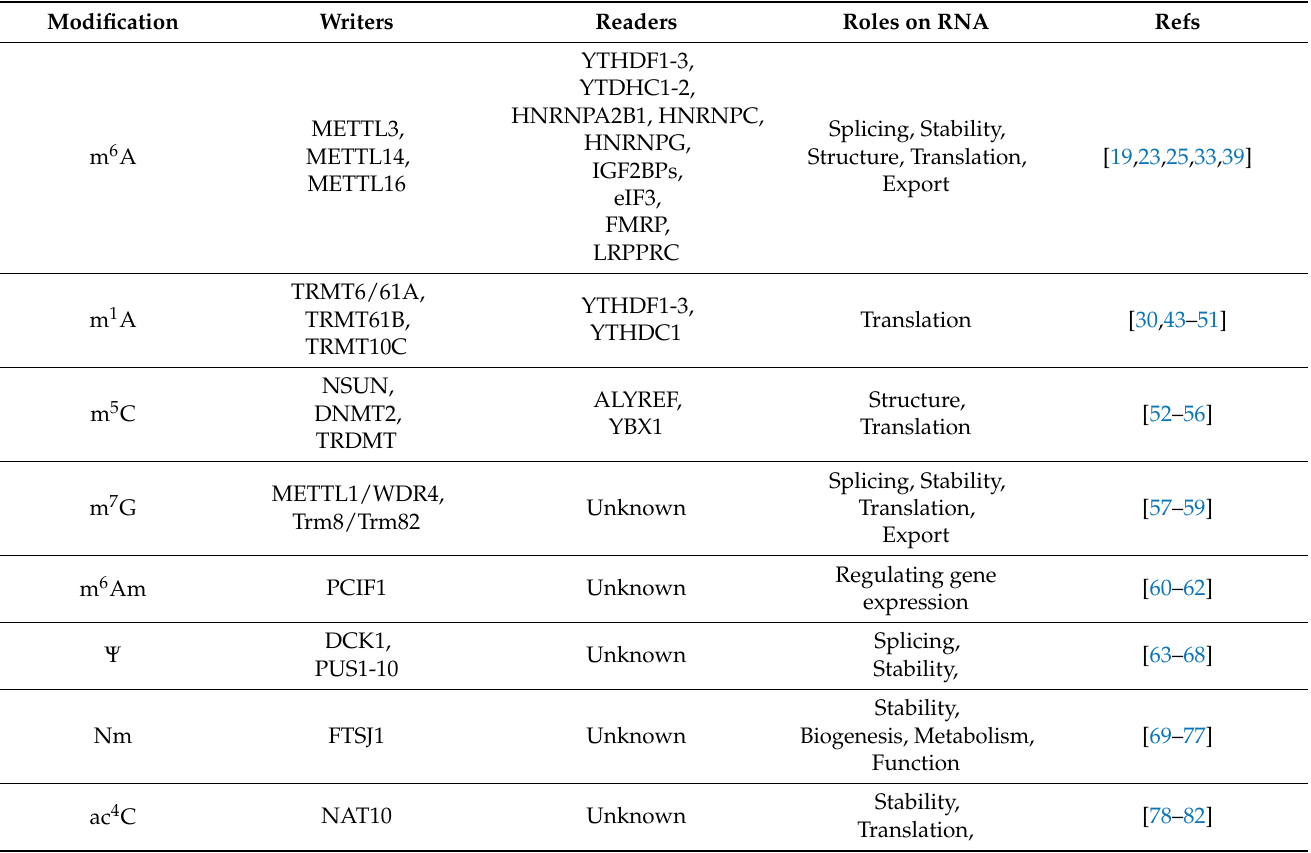
Table 1. Summary of writer and reader proteins for common mRNA modifications and the effects of these modifications on cellular